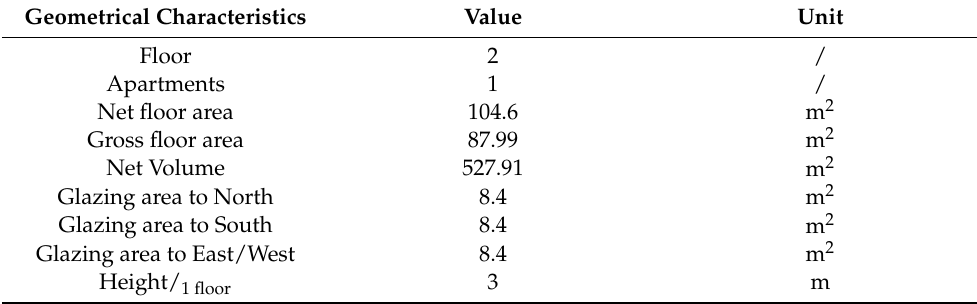
Table 4. Thermal properties of the single-family building. Table 3. Geometrical characteristics of the single-family building.